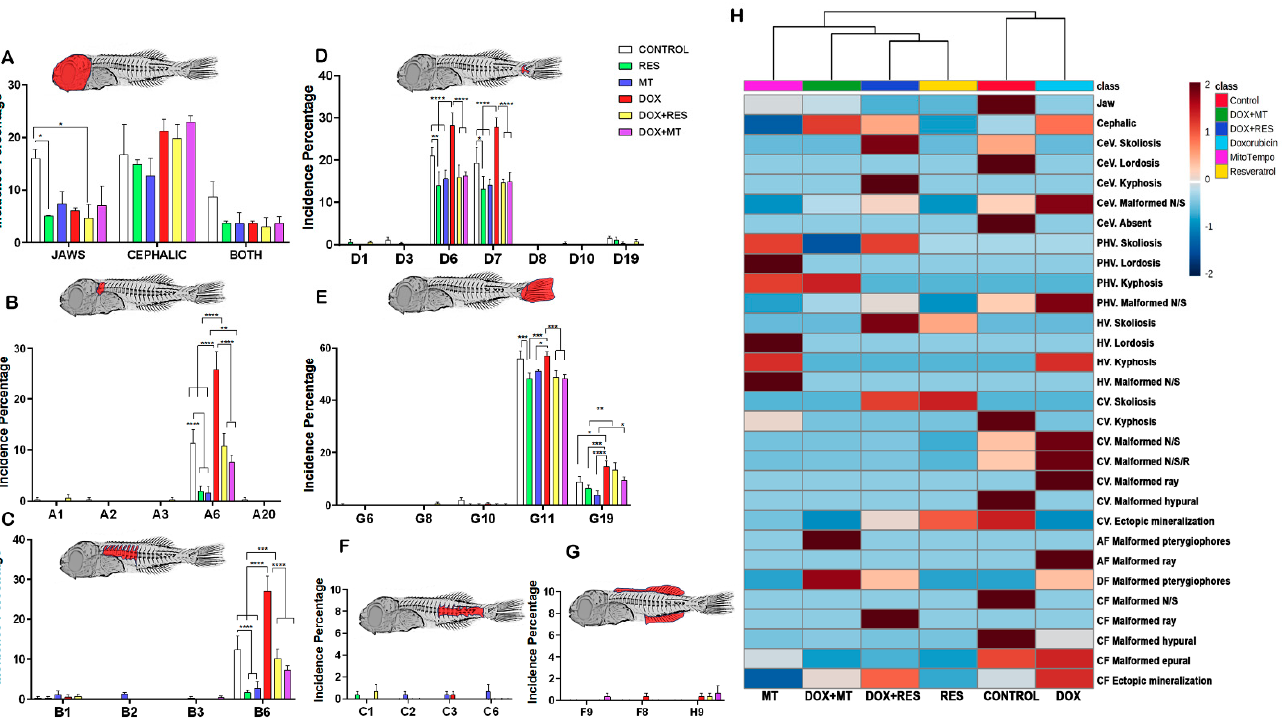
Figure 4. Distribution of skeletal deformities. Incidence of deformities in between the antioxidant and pro-oxidant supplemented groups. Head region ( A ), cephalic region ( B ), prehaemal region ( C ), caudal region ( D ), caudal fin ( E ), haemal or pre-caudal region ( F ), anal fin ( F ), dorsal fin ( G ), and heat map of the specific deformities between the antioxidant and pro-oxidant supplemented groups ( H ). Two-way ANOVA, Tukey’s multiple comparisons test, *— p ≤ 0.05, **— p ≤ 0.01, ***— p ≤ 0.001, and ****— p ≤ 0.0001. Acronyms: resveratrol (RES), doxorubicin (DOX), MitoTEMPO (MT), doxorubicin + resveratrol (DOX+RES), doxorubicin + MitoTEMPO (DOX+MT), Cephalic vertebrae (CeV), Pre-haemal vertebrae (PHV), Haemal vertebrae (HV), Caudal vertebrae (CV), Anal fin (AF), Dorsal fin (DF), and Caudal fin (CF).